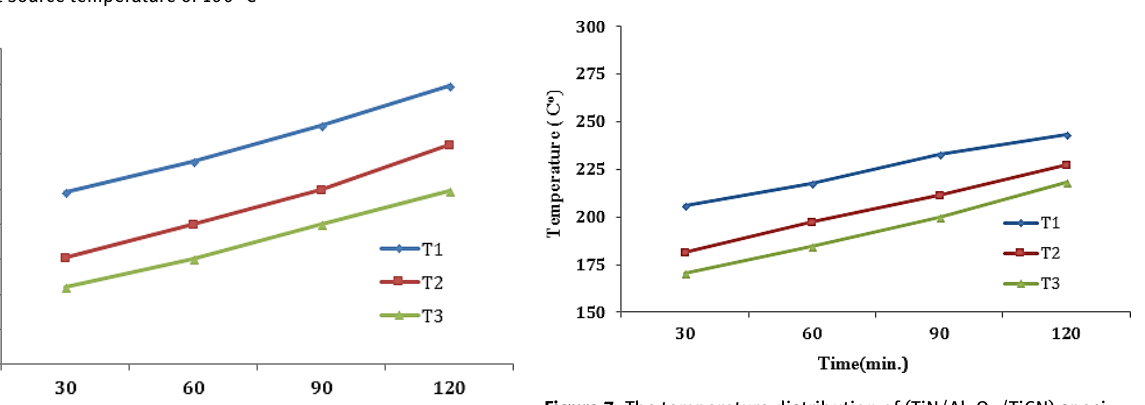
temperatures increase with increasing exposure time to the 100 ∘ C steady-state furnace temperature. The temperature difference ( T 1 − T 3 ) between the copper and test specimens was 35.2 ∘ C for the uncoated specimen and 29.8 ∘ C for the TiN/Al 2 O 3 /TiCN specimen because the uncoated specimen